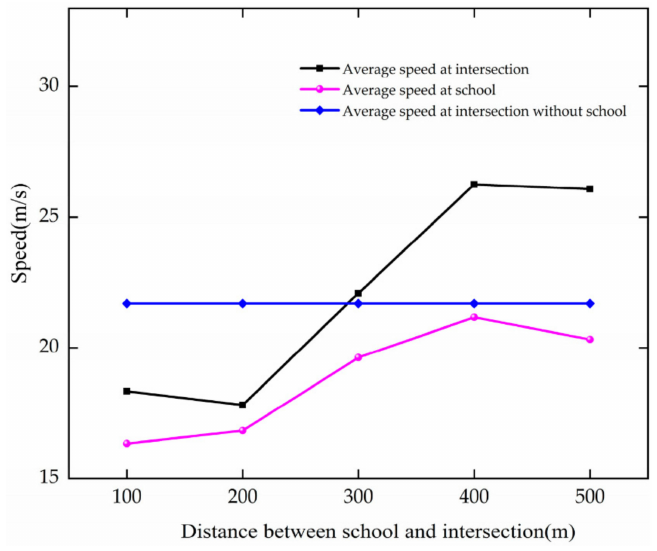
Figure 21. Variation trend of average speed with DSI.